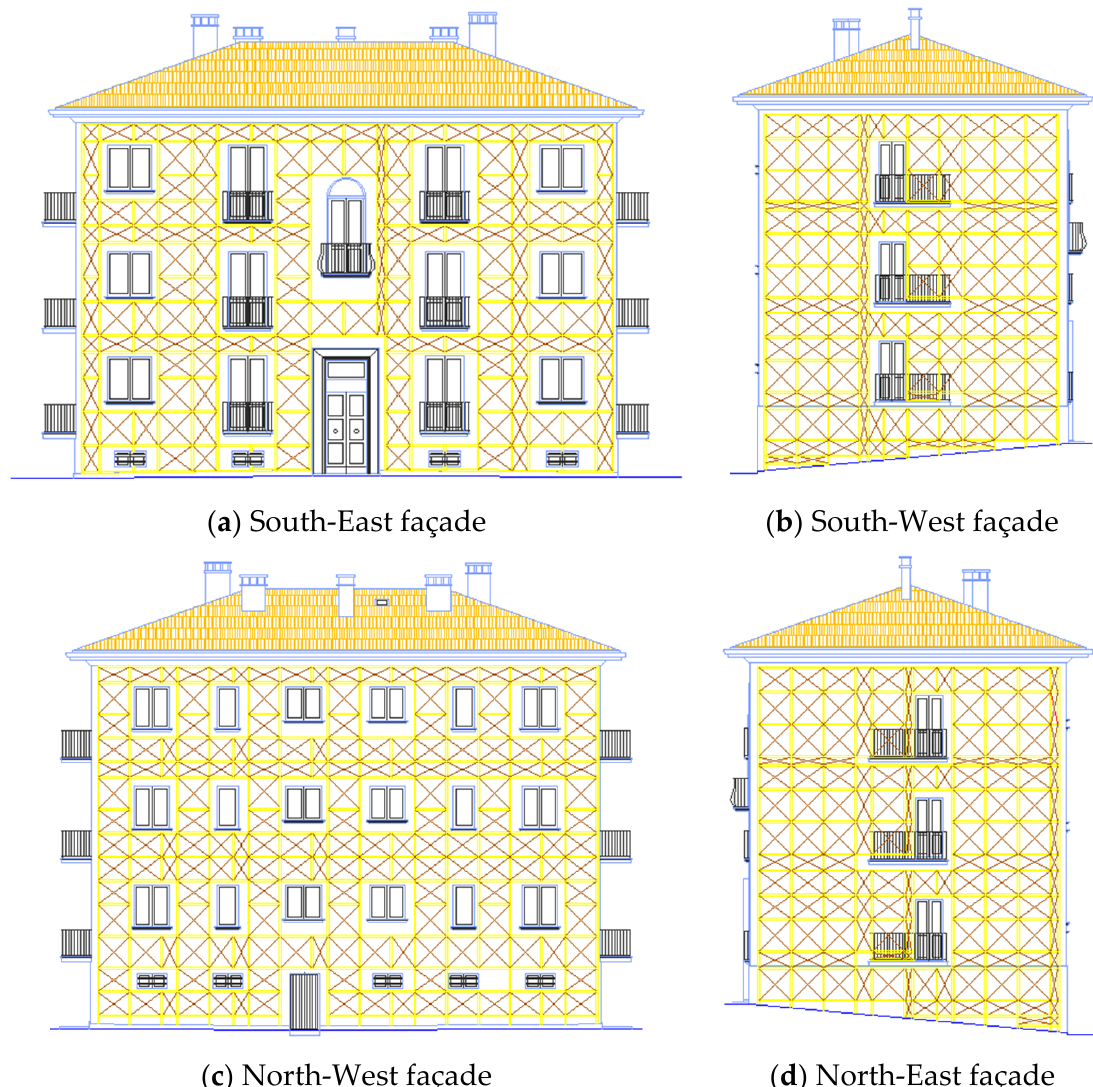
Figure 16. Application of the Resisto 5.9 coat system on the building facades (North-East ( a ), South- East ( b ), South-West ( c ) and North-West ( d )).